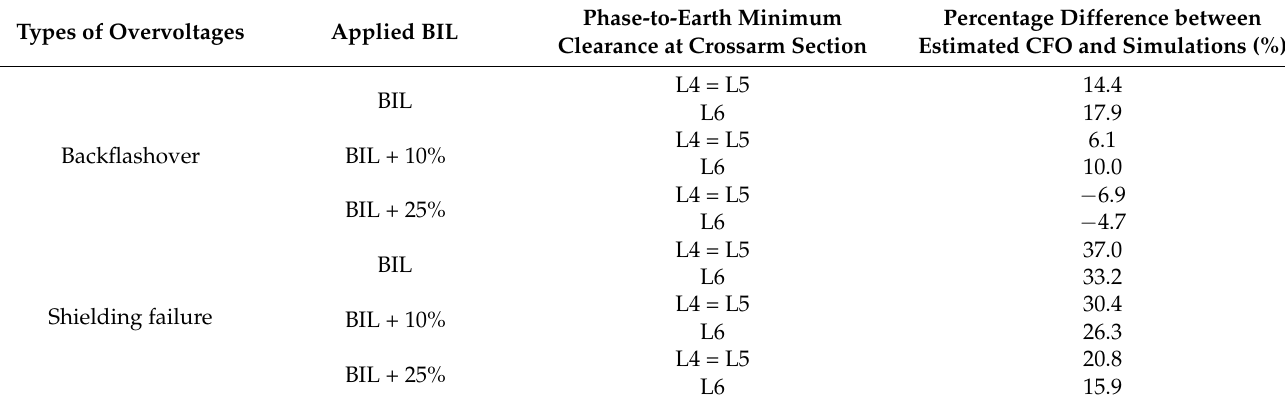
Shielding failure